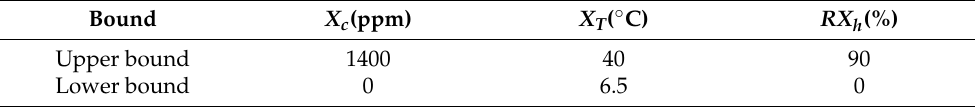
Table 3. Bounds of greenhouse climate.